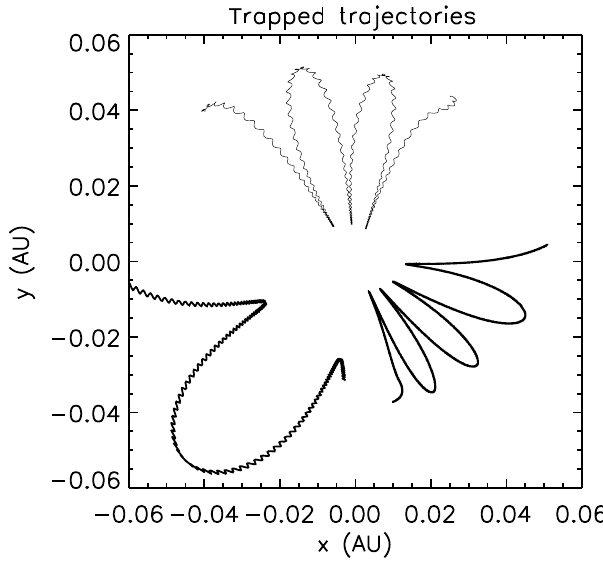
Figure 14. Trapped particle trajectories projected onto the ( x , y ) plane. The top ( Q/m = 10 − 5 e/m p ) and bottom right ( Q/m = 10 − 4 e/m p ) trajectories follow from simulations for the case of the time-extended (6.11 days long) CME model. For comparison, a tra- jectory obtained in the model with constant plasma speed and Parker spiral magnetic field is shown in the lower left part of the figure.